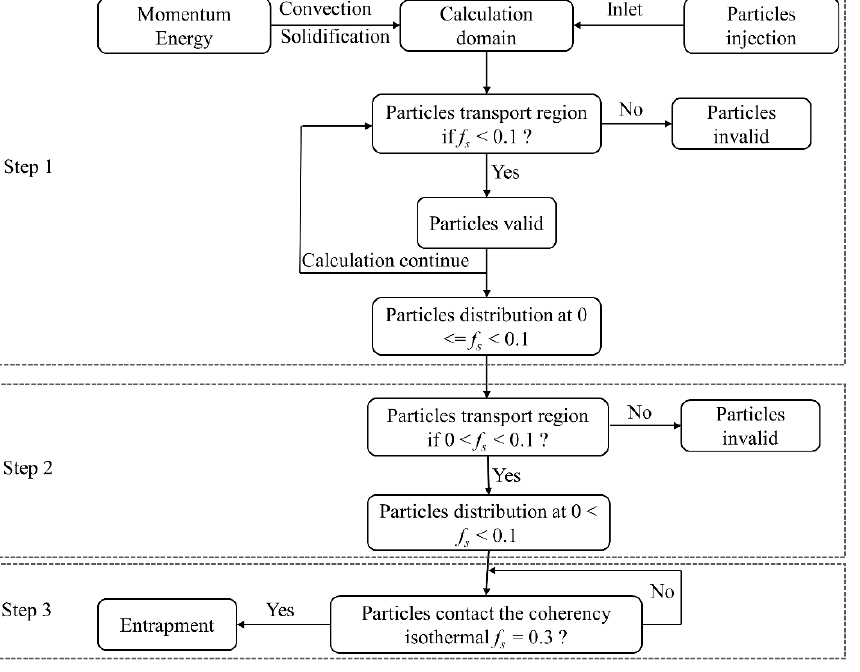
Figure 1. Flow chart of the particles motion and entrapment simulation.